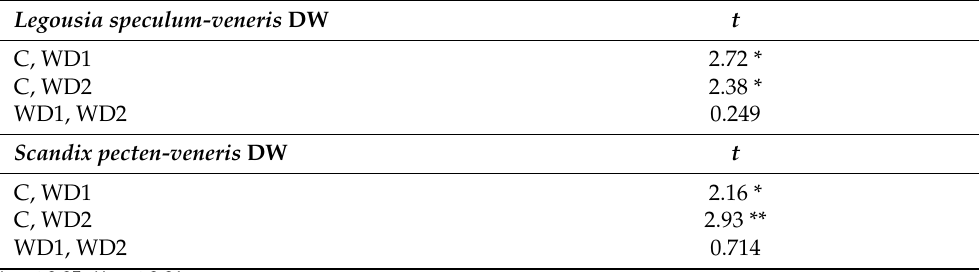
Table 4. Results of PERMANOVA pairwise t -tests (dry weight) between treatments; DW = Dry Weight; C = 0% wood distillate; WD1 = 0.2% wood distillate; WD2 = 0.5% wood distillate.